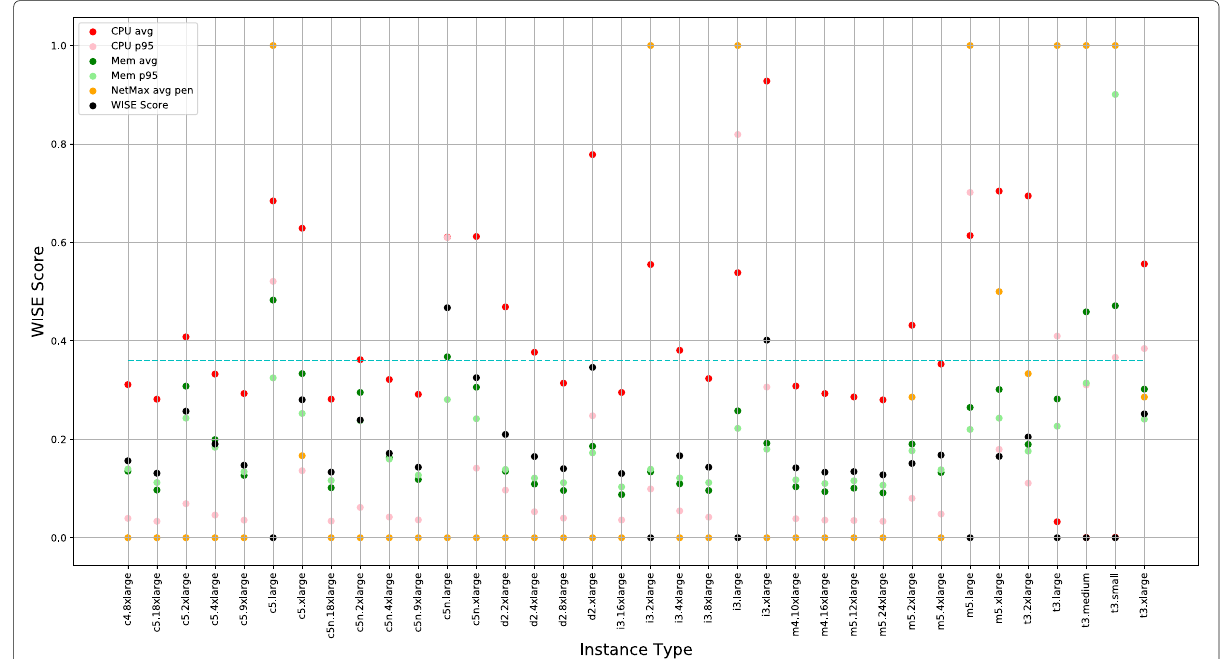
Fig. 10 WISE scores using the exponentially monotone function and (cid:4) 1 -norm for Streaming